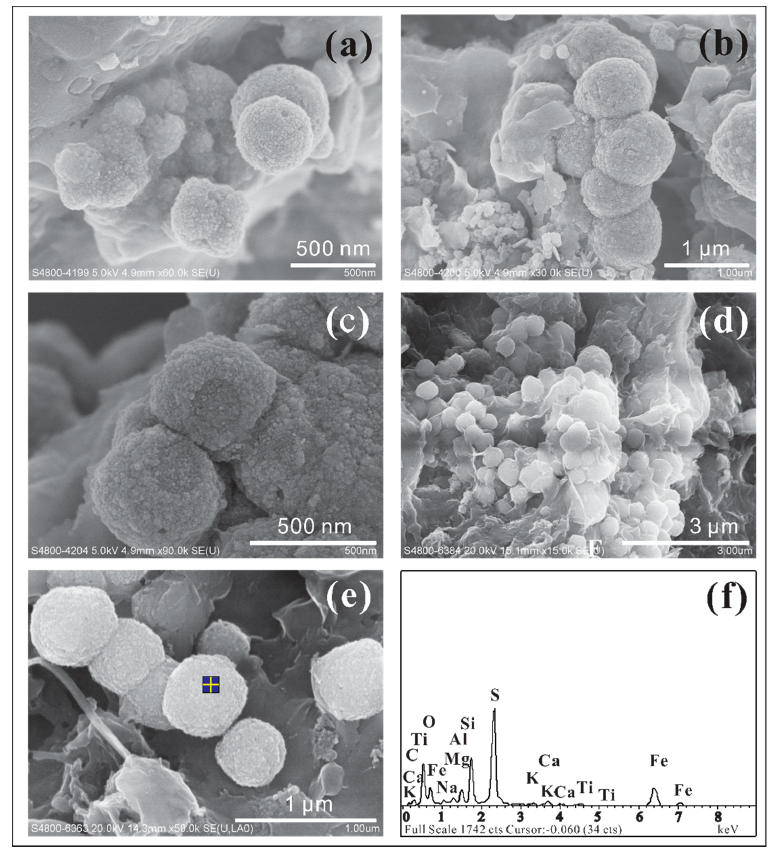
Figure 10. SEM images and the EDS result of spherulitic pyrite crystals that are characterized by biofilm covering materials ( a – e ), aggregated either loosely ( a ) or tightly ( b ). ( f ) is the EDS profile of the pyrite crystal in ( e ).